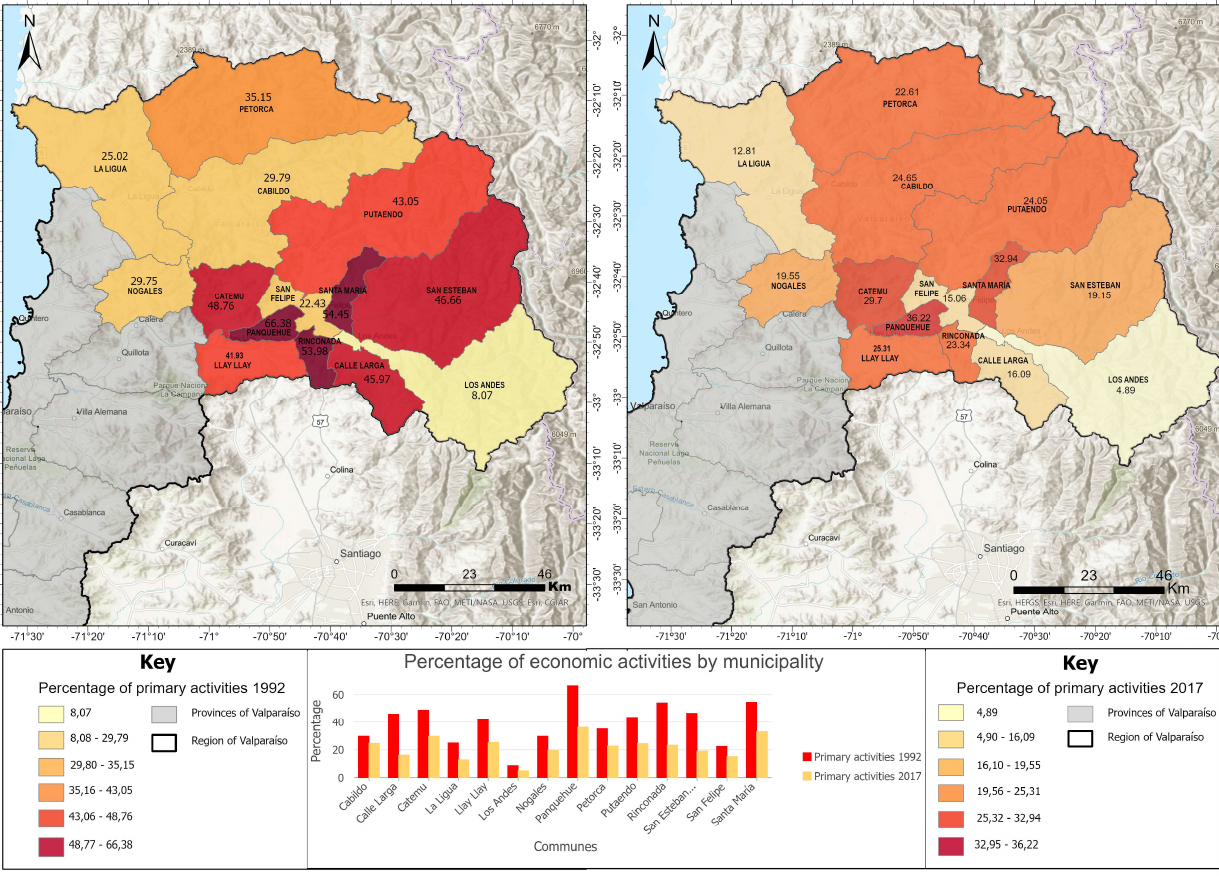
Figure 8. Decline of the primary productive sector, 1992–2017.